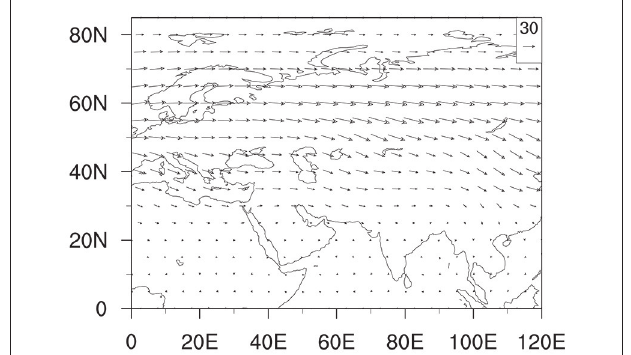
FIGURE 11 | Horizontal distribution of the wave activity flux (vector; unit: m 2 s − 2 ) field at 250 hPa averaged from day − 10 to day